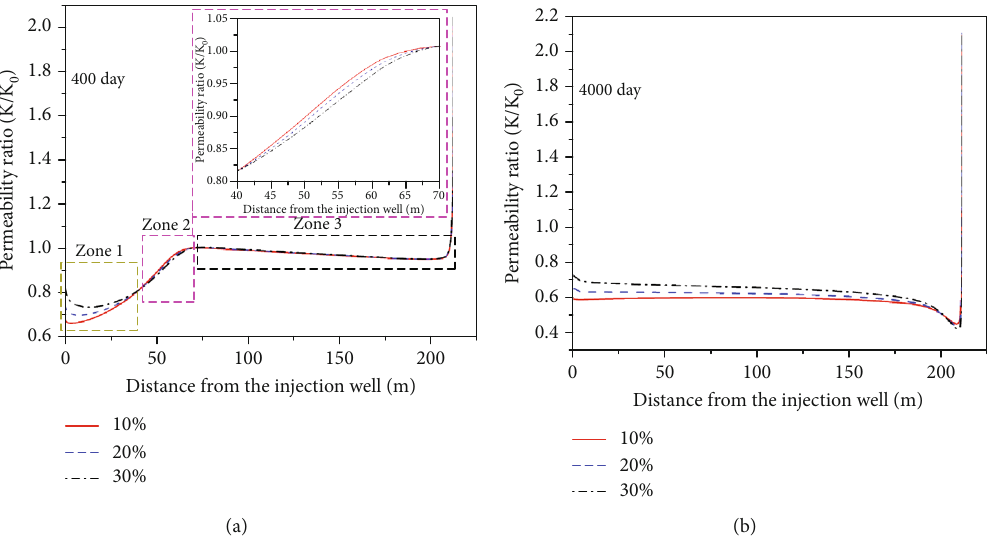
Figure 21: Evolution of permeability ratio along reference section A-B. (a) Permeability ratio at 400 days. (b) Permeability ratio at 4000 days.